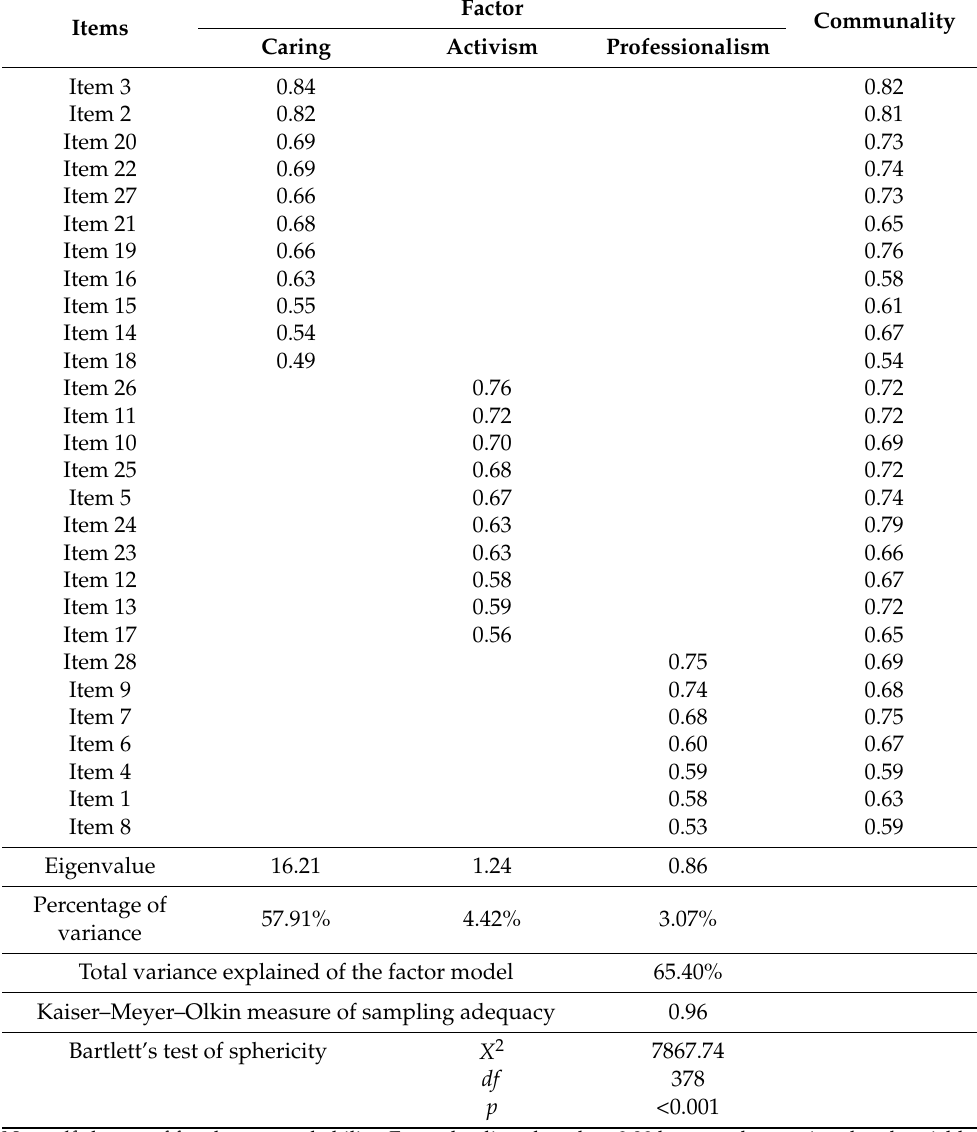
Table 2. Factor loading and communality of the Indonesian version of the Nurse Professional Values Scale-3 (NPVS3-I) ( n =